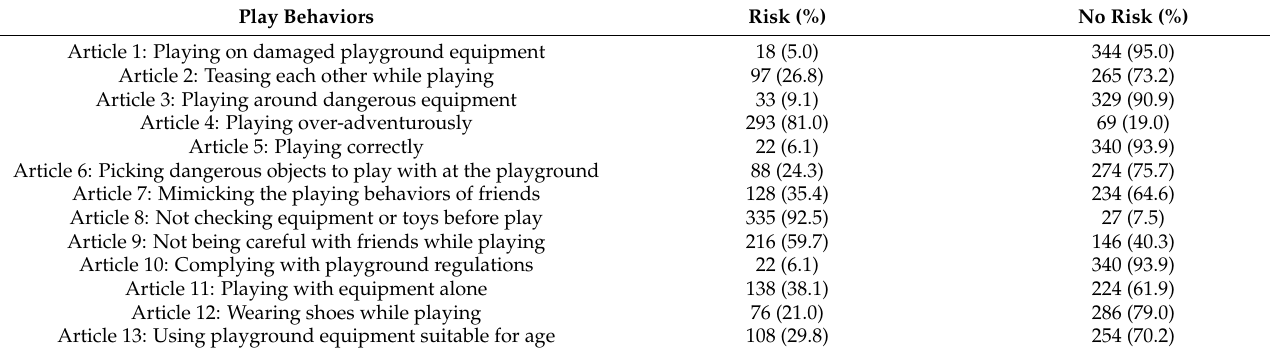
Table 3. Play behavior ( n =